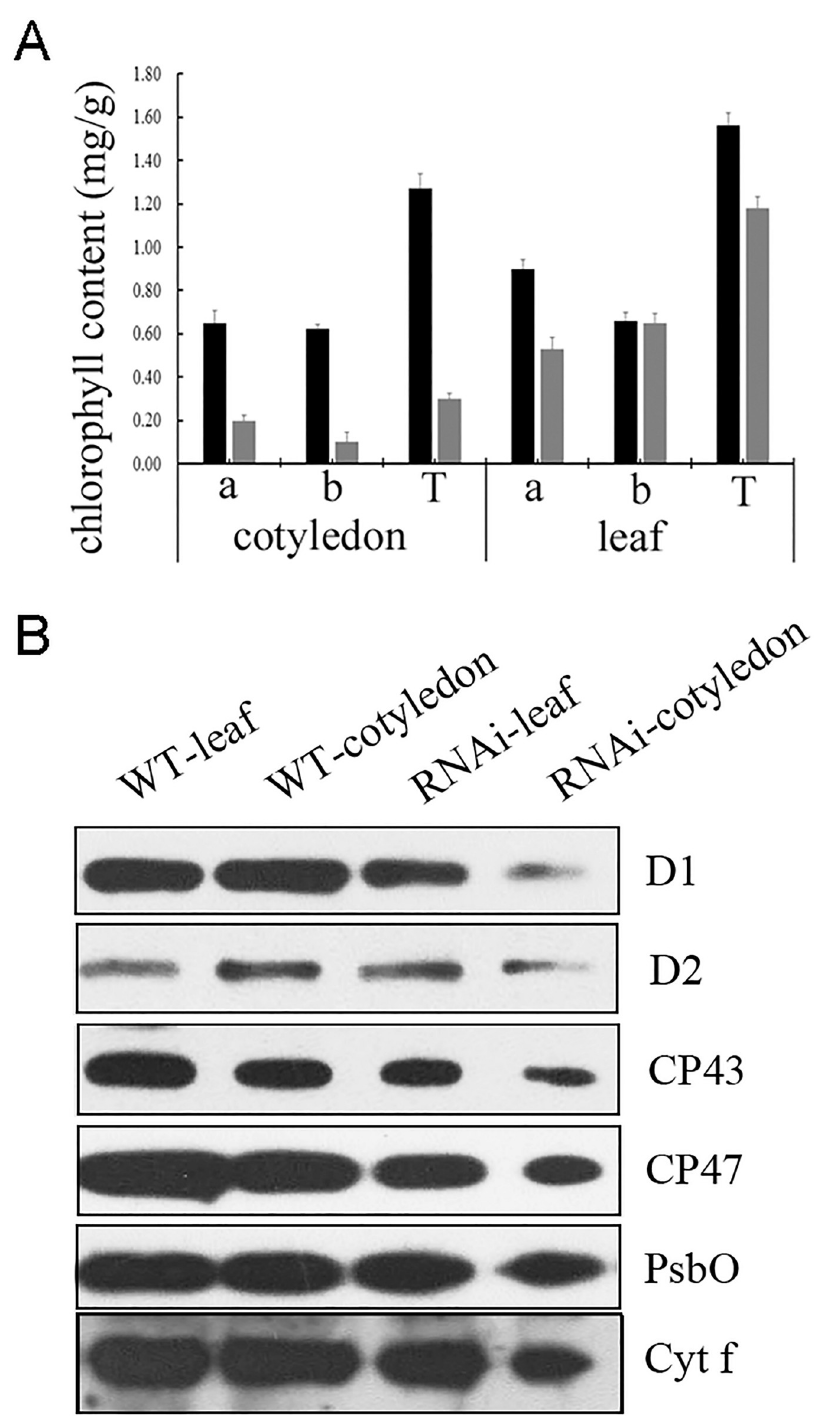
Fig 7. Defects in the PSII complex of the RNAi- Ftshi4 mutant block energy transfer within PSII. A, The chlorophyll concentrations of wild-type and RNAi- FtsHi4 mutant cotyledons and true leaves. B, Immunoblot analyses for the accumulation of D1, D2, CP43, CP47, PsbO, and Cyt f proteins in wild-type and RNAi- FtsHi4 mutant cotyledons and true leaves. The thylakoid membrane proteins were fractionated by SDS-urea-PAGE, and the blots were probed using antibodies raised against D1, D2, CP43, CP47, PsbO, or Cyt f, respectively.